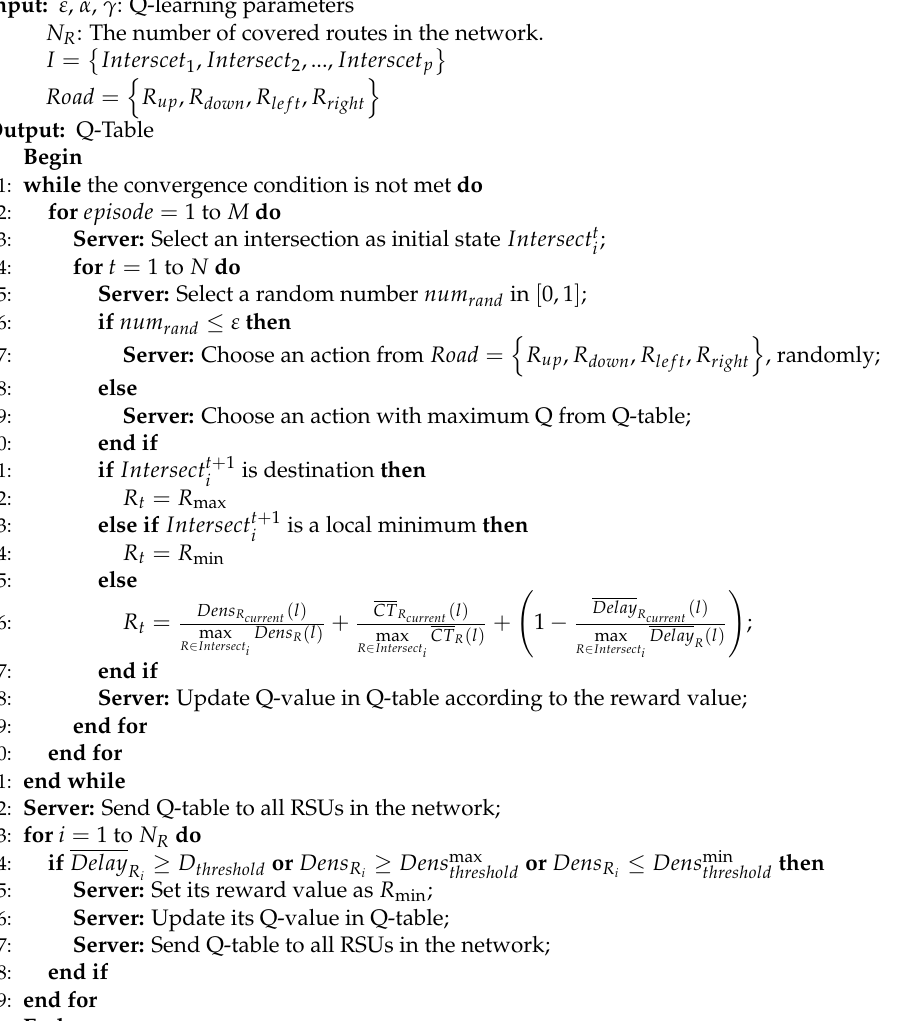
Algorithm 2 Global view based-routing